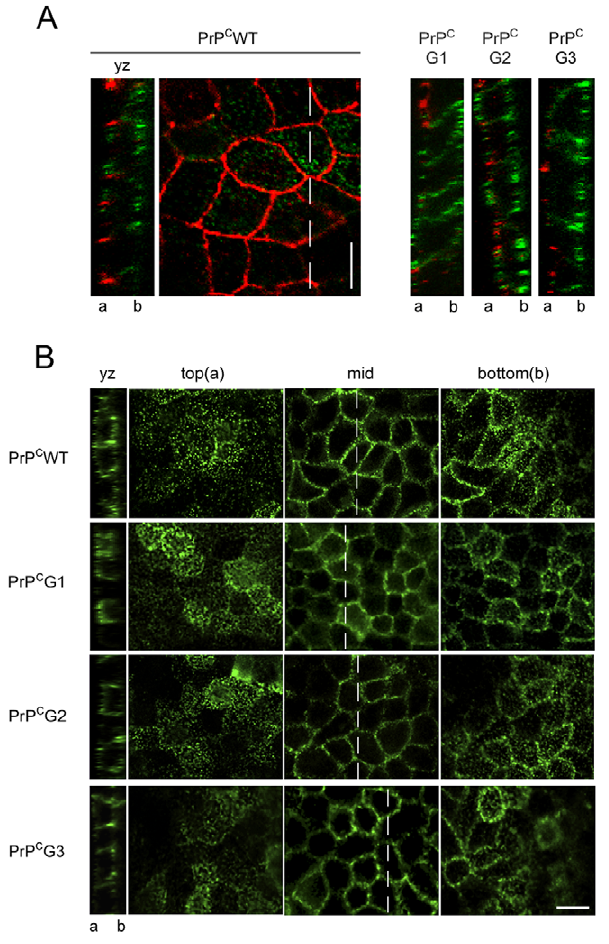
Figure 3. N-glycosylation of PrP C affects polar sorting in MDCK cells. MDCK cells stably expressing PrP C WT, PrP C G1, PrP C G2 or PrP C G3 were grown in Transwells for 4 to 5 days until they were fully polarized. (A) Cells were separately stained with the 3F4 antibody (green) followed by permeabilisation and staining with an antibody against ZO-1 (red), a constituent of tight junctions, indicating the cell polarity. Confocal microscopy of a Z-stack of PrP C WT (left) at the level of tight junctions stained with ZO-1, and YZ-sections (right) of all glycomutants indicate both the integrity of the polarized monolayer and a redistribution of PrP C G1 and PrP C G2 to the apical compartment when compared to PrP C WT and PrP C G3. Localization of the apical (a) and basolateral (b) compartment is indicated. (B) After immunocytochemistry under non- permeabilising conditions with the 3F4 antibody, serial Z-stacks from the bottom to the top were taken with confocal microscopy. YZ images shows transversal cut trough cells at the mid level, marked with a dashed line. PrP C WT and PrP C G3 were mainly found in the basolateral compartment whereas PrP C G1 and PrP C G2 were mainly found in both compartments. Scale bars represent 10 m m.